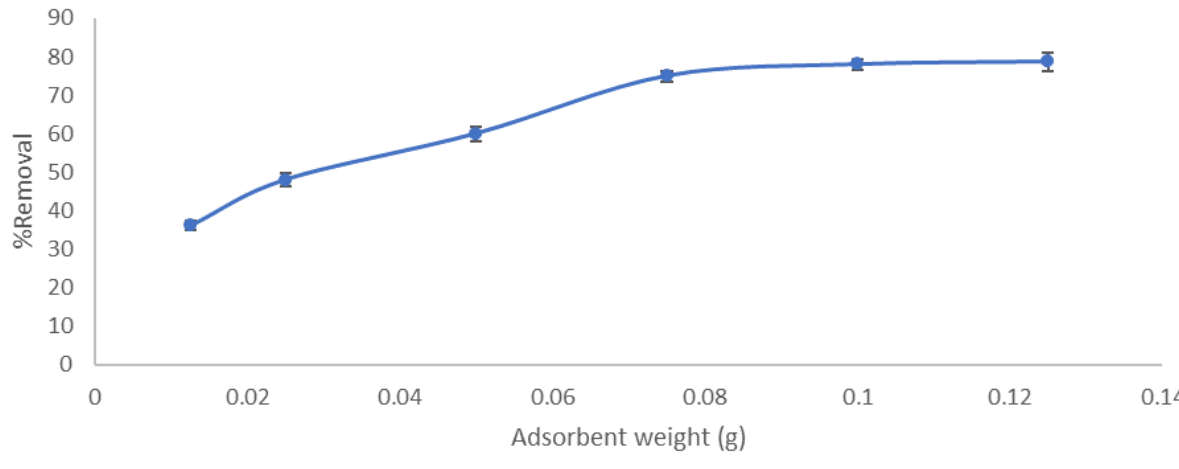
Figure 8. Effect of adsorbent weight on % removal of CV using LCF.